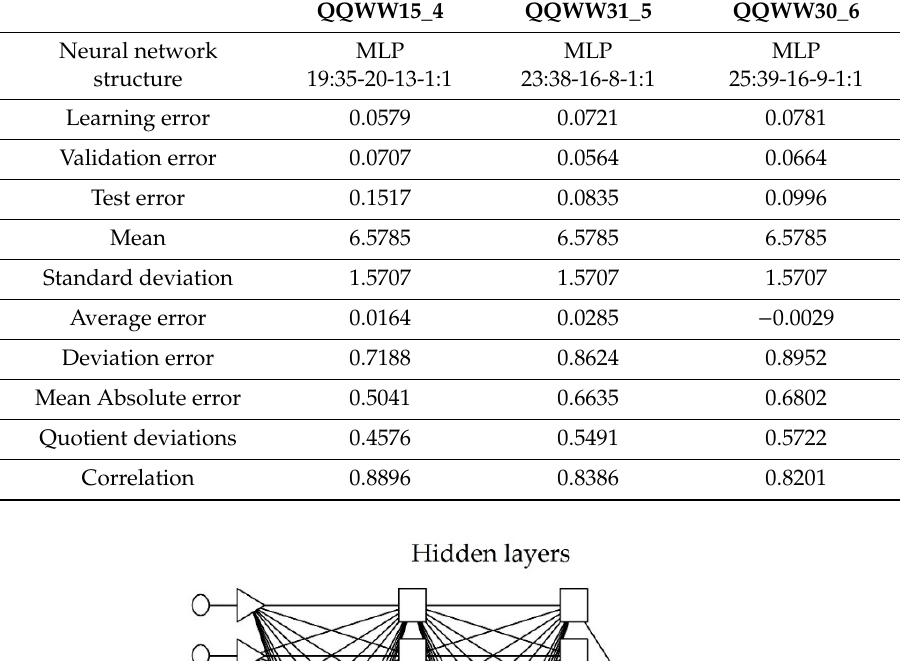
Table 3. The quality and structure of the neural models produced.